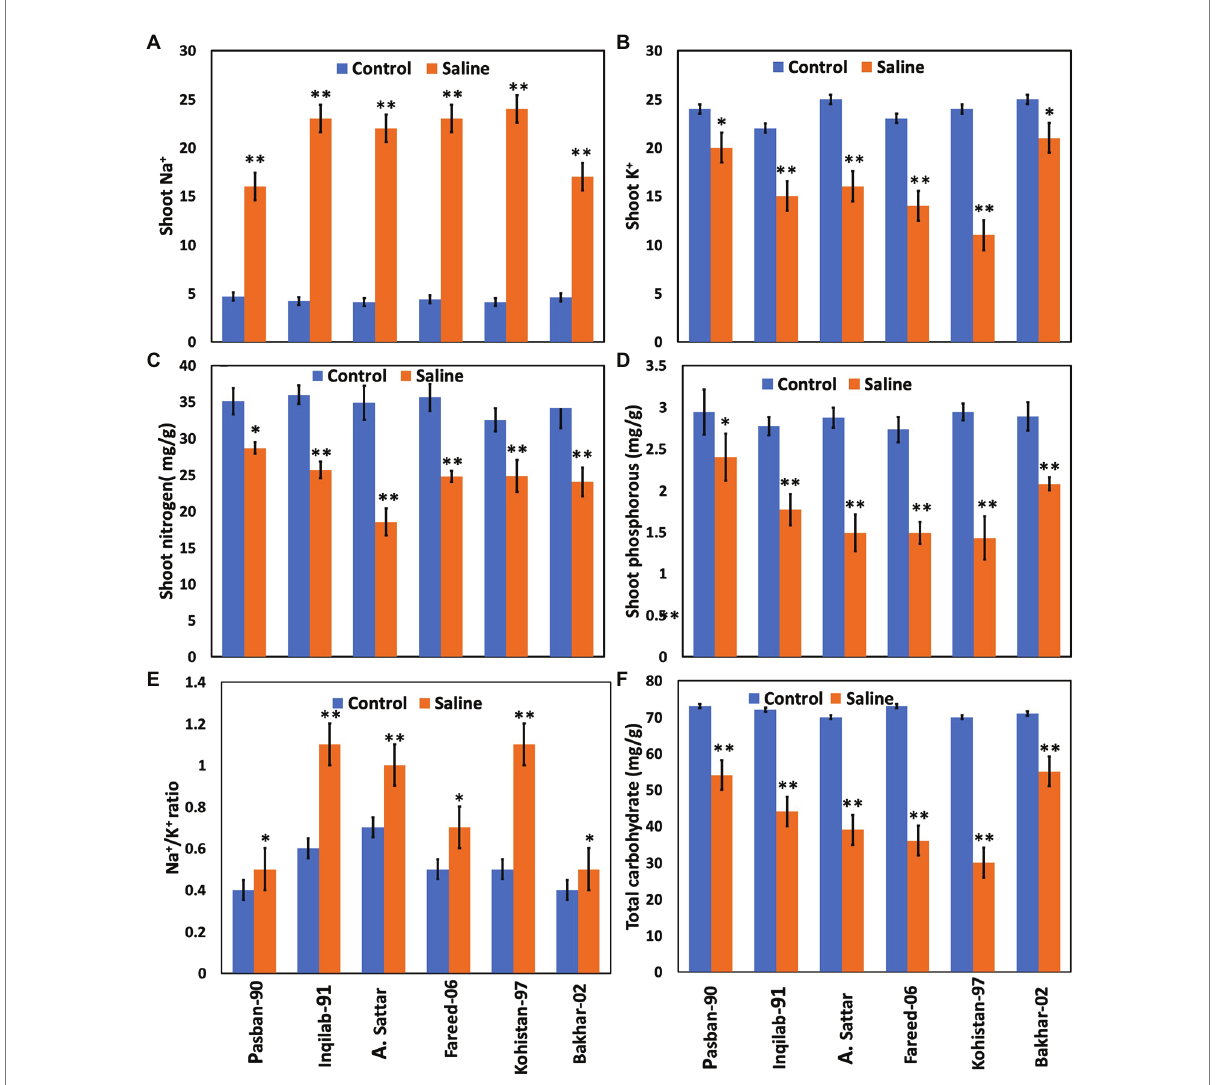
FIGURE 5 Biochemical attributes and total carbohydrates of six wheat varieties under salt stress (150 mM) and control condition (0 mM). (A) Shoot Na + , (B) shoot K + , (C) shoot nitrogen, (D) shoot phosphorous, (E) Na + /K + ratio, and (F) total carbohydrate. Bars indicate ±. Means values are indicated on the vertical axis. Asterisks (**) indicate that the trait mean was significantly different (value of p < 0.01) between the salt and control